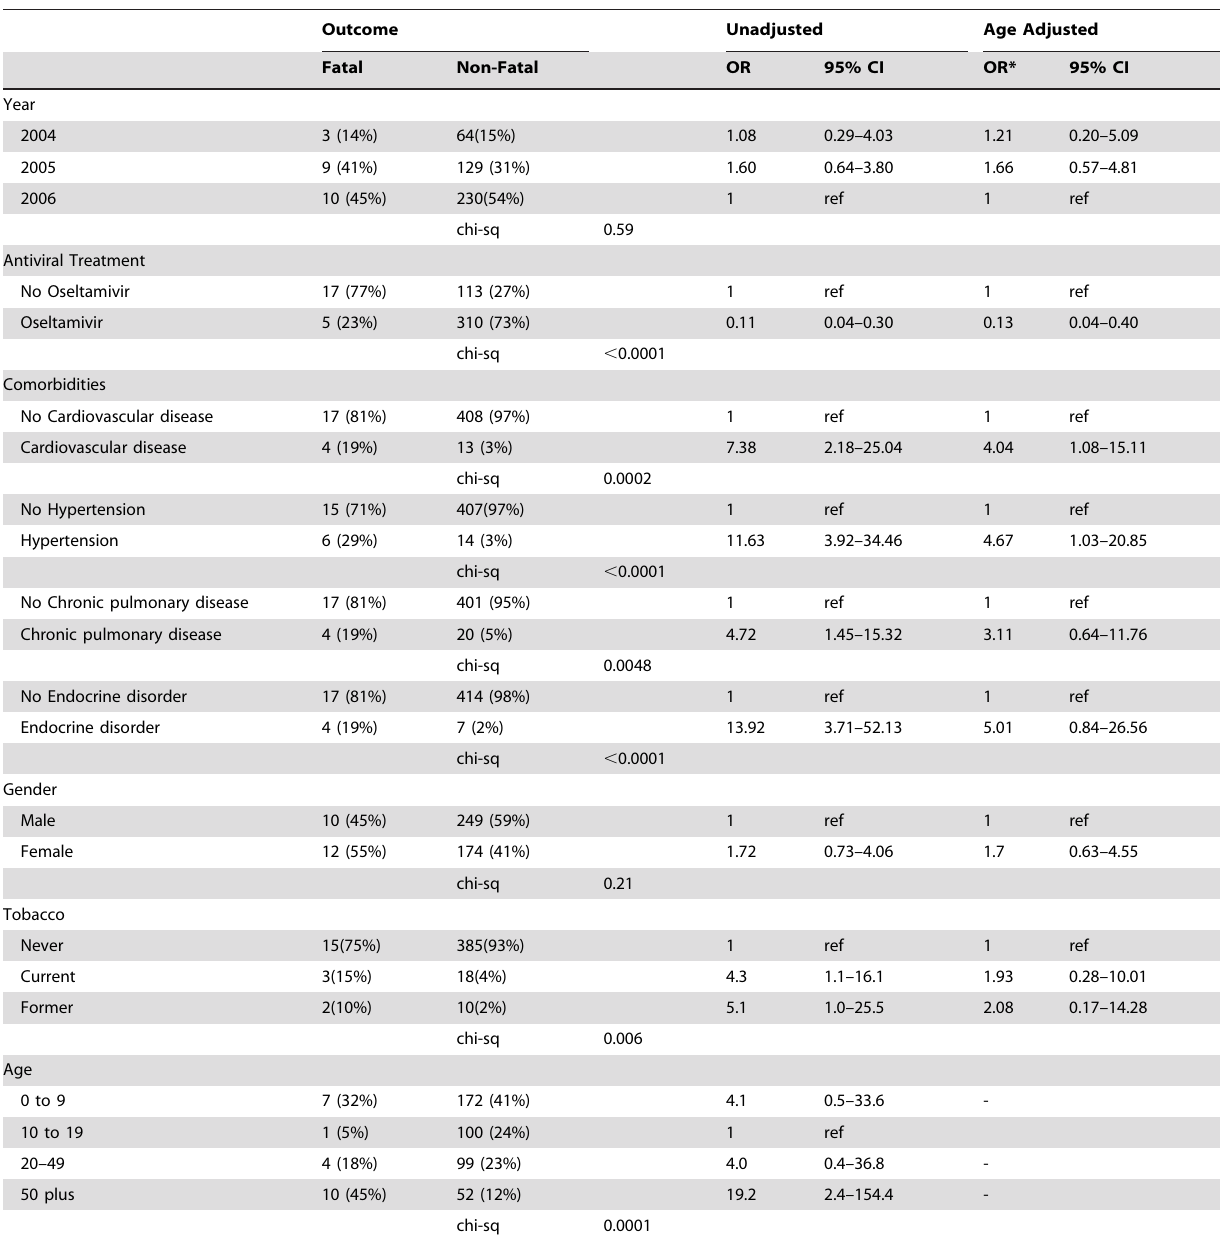
Table 3. Factors associated with a fatal